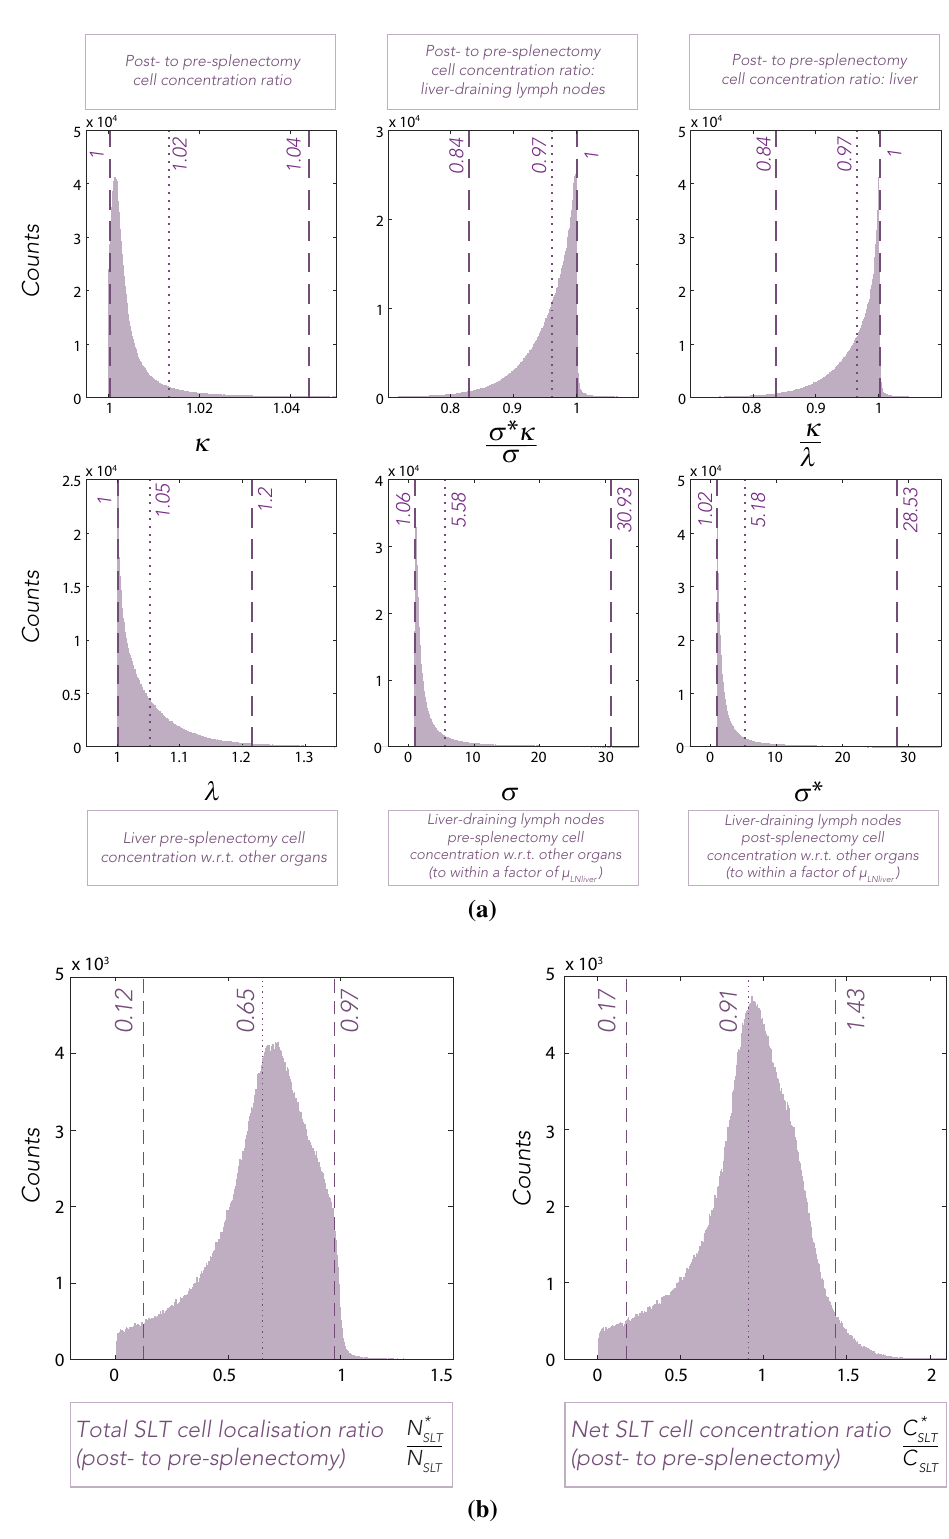
Figure 5. Distributions of ( a ) post- to pre-splenectomy cell concentration ratios: κ , σ ∗ κ/σ and κ/ (cid:31) , as well as (cid:31) , σ and σ ∗ , and ( b ) the post- to pre-splenectomy total T cell localisation ratio and the net T cell concentration ratio in the SLT. Dotted and dashed lines correspond to means and 95% confidence intervals of the plotted distributions. See “Parameterisation” and “In silico splenectomy—simulation” sections for details on